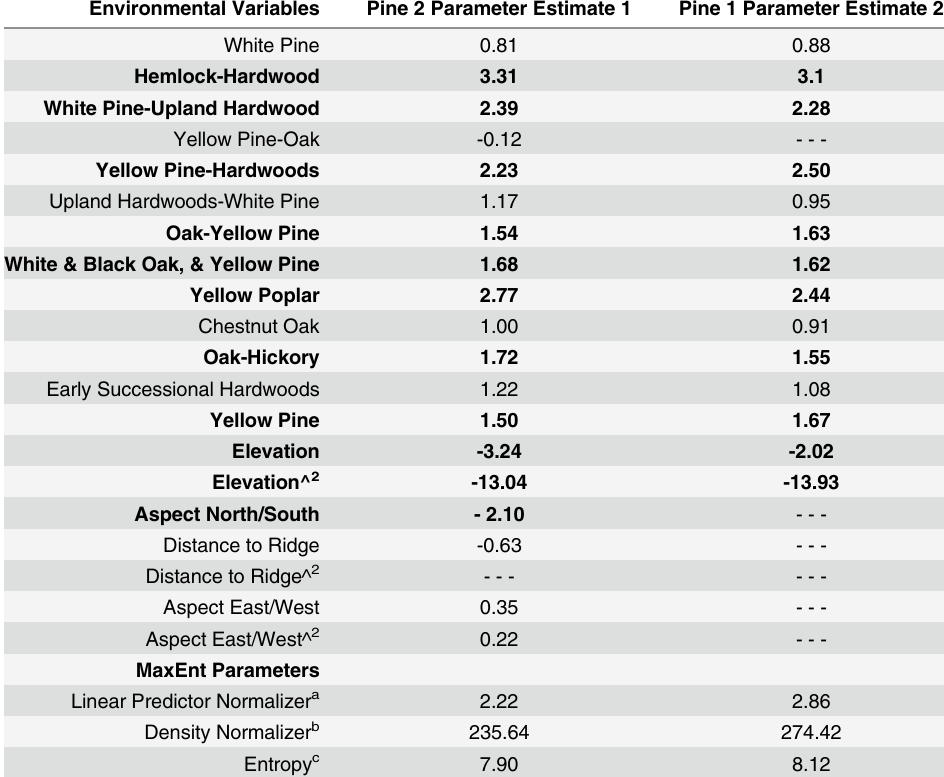
Table 5. Parameter estimates for two top-ranked models.